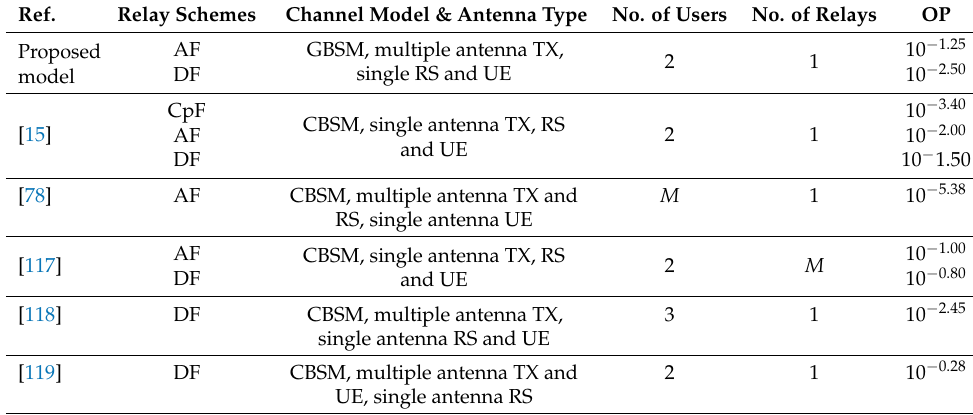
Figure 9. Outage probability comparison of two users using AF and DF schemes of the proposed channel models with ( a ) CA and ( b ) URA. Table 4. Comparison of Outage Probability with prior works at SNR of 15